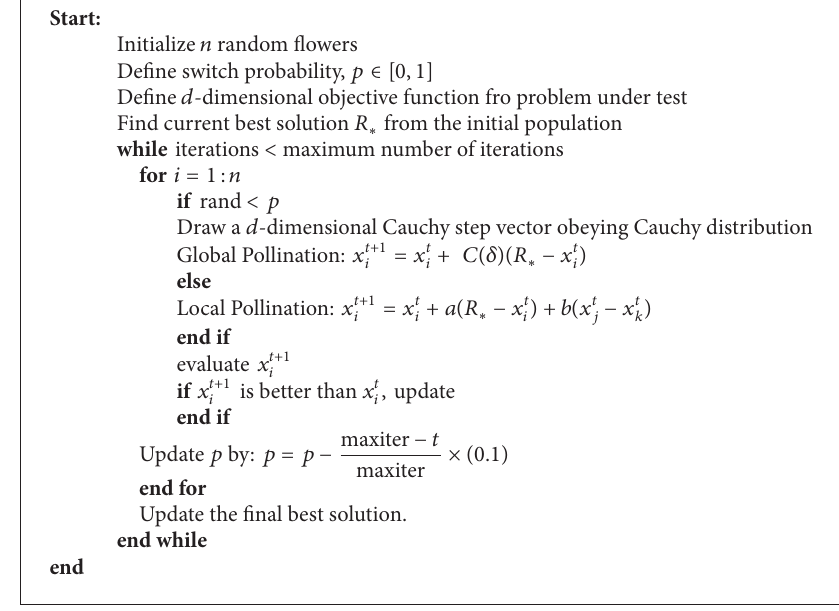
Pseudocode 1: Pseudocode of